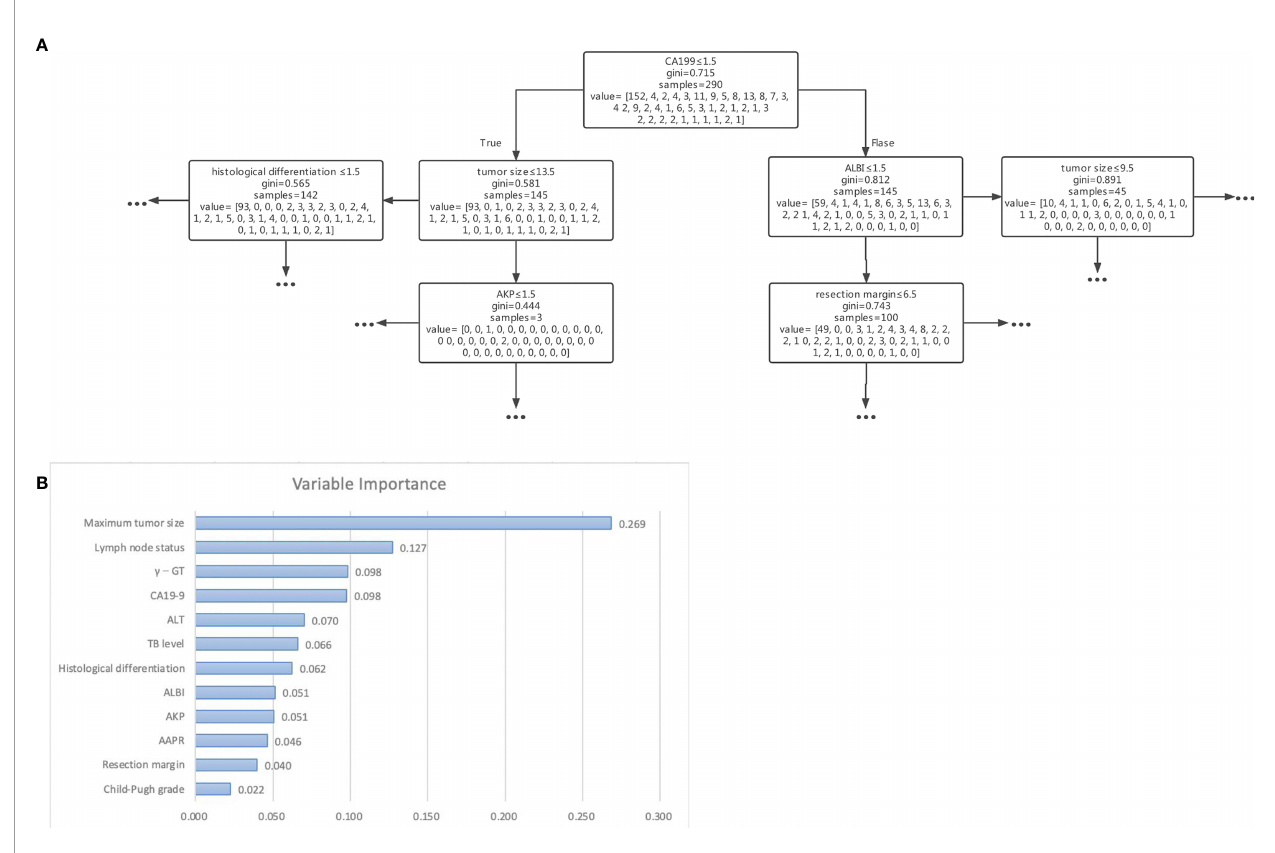
FIGURE 3 | (A) Schematic representation of the decision tree analysis based on 12 variables used to predict outcomes in patients after resection for cholangiocarcinoma. (B) The importance of each variable in the decision tree analysis based on 12